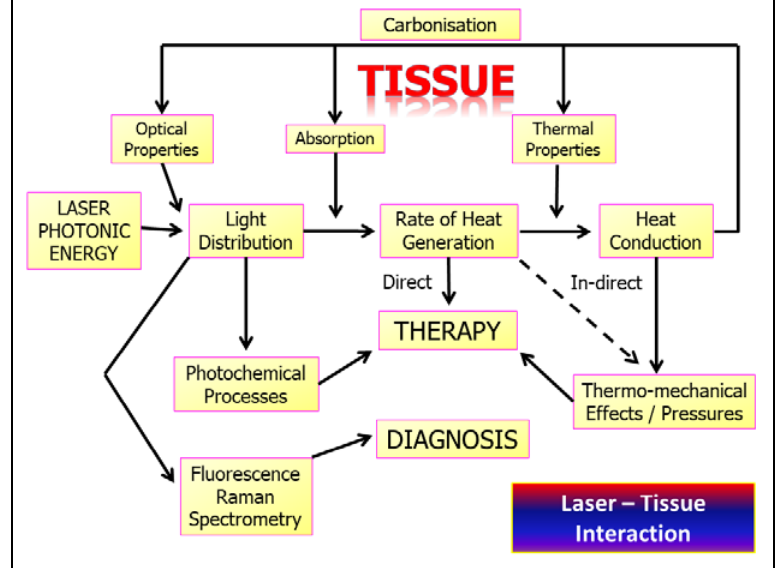
Figure 11. Algorithm depicting the multi-level interaction of varying incident photonic energy as applied to target tissues of quantifiable optical properties. Of prime concern is the thermal containment of laser–tissue interactions. Excessive application of incident power may cause overheating and carbonisation, leading to aberrant interactive effects.